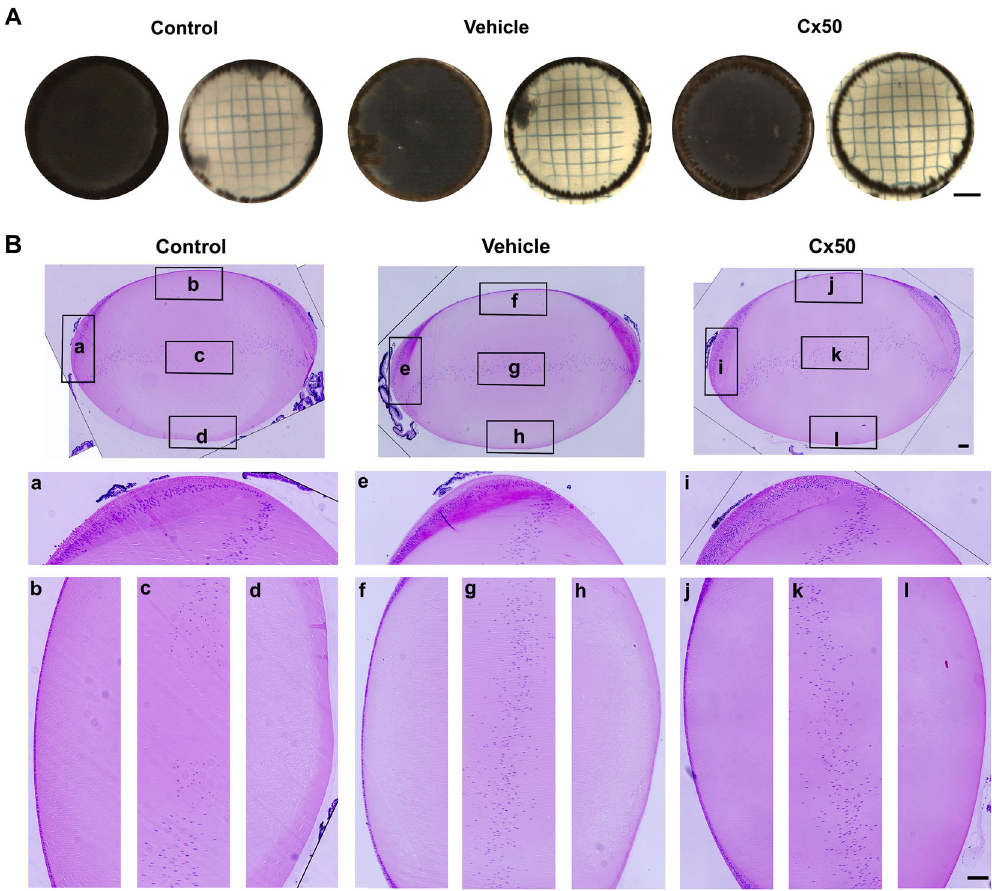
Fig. 2 Exogenous expression of WT Cx50 has no effect on lens transparency and structure. A Embryonic day 20 lenses with or without injection of recombinant retrovirus containing vehicle or Cx50 were imaged with (right panels) or without grids (left panels). Scale bar: 400 µ m. B Paraf fi n lens sections were stained with H&E. Images of midsagittal paraf fi n tissue sections of lenses injected with a retrovirus containing vehicle or Cx50 were captured with a Keyence BZ-X710 microscope. As indicated by black framed boxes in the entire lens: (a, e, and i) lens equator region; (b, f, and j) lens anterior region; (c, g, and k) lens central region; (d, h, and l) lens posterior region. Scale bar: 50 µ